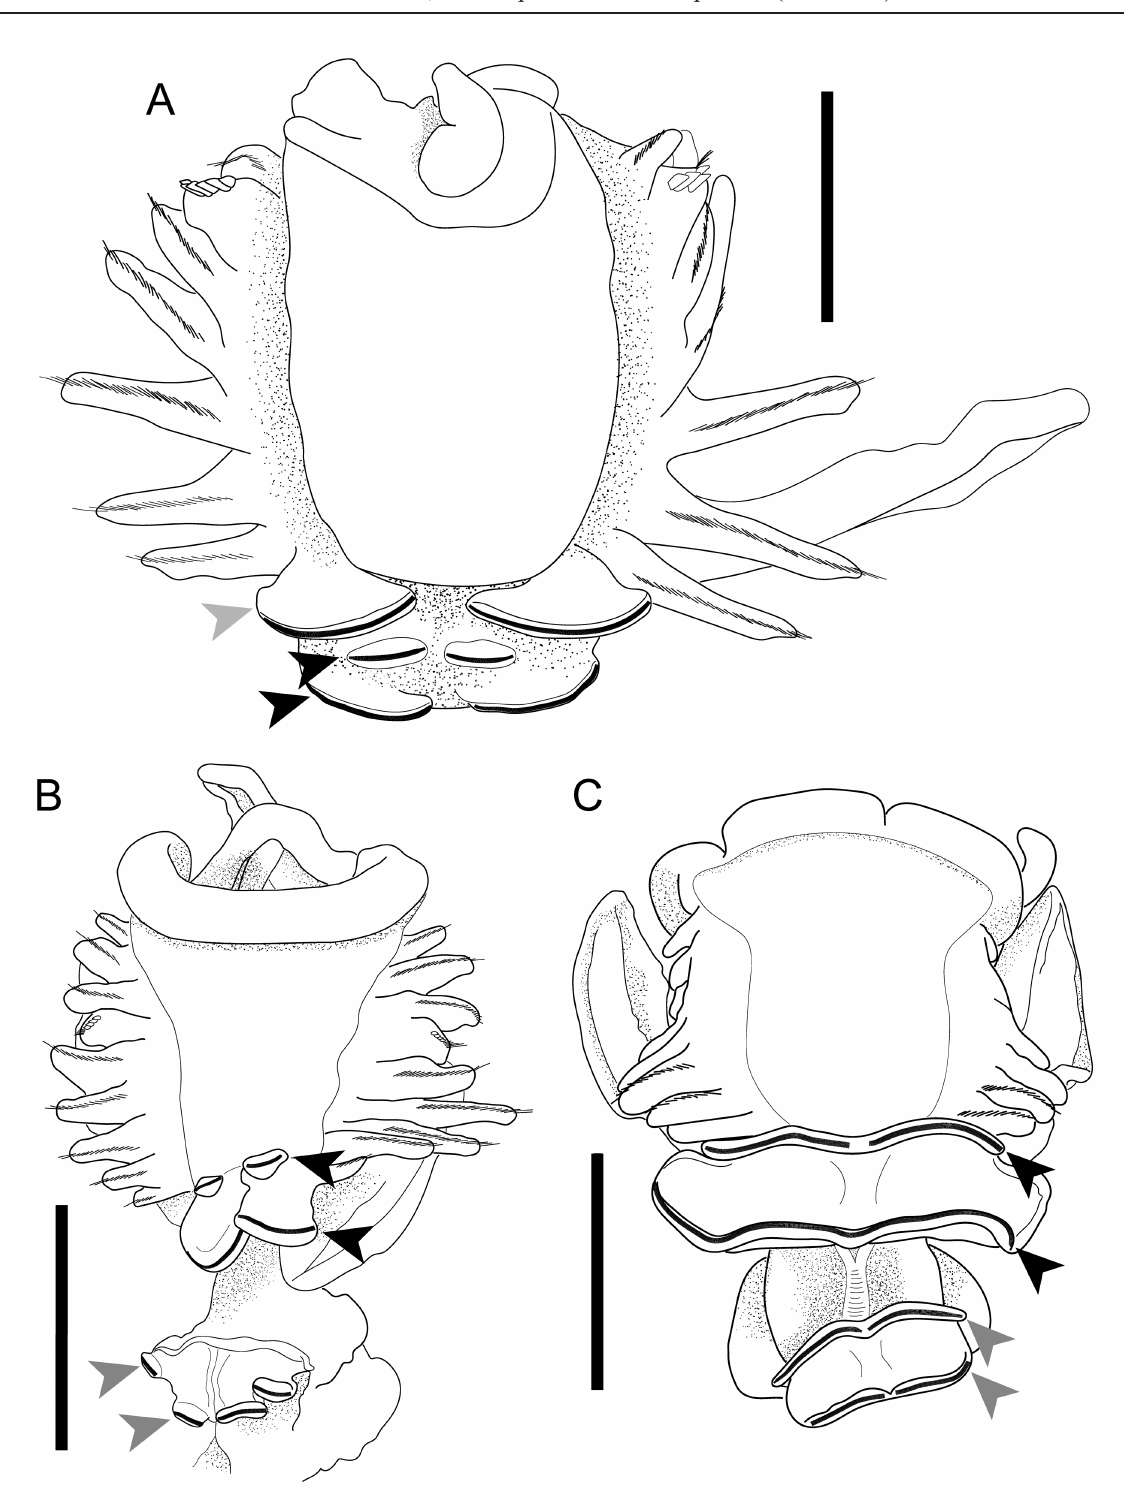
Fig. 3. Illustrated differences in A9, B1, and B2 neuropodial structures among species. A . Chaetopterus norvegicus M. Sars, 1835, paralectotype NHMO C5877, anterior ventral view to segment B1. B . Chaetopterus bruneli sp. nov., holotype CMNA 2015-0016, anterior ventral view to B2. C . Chaetopterus longipes Crossland, 1904 (UF 5920) from Japan, anterior ventral view to B2. Light grey arrows indicate segment A9 neuropodia, black arrows indicate segment B1 neuropodia, and dark grey arrows indicate segment B2. Scale bars: 2